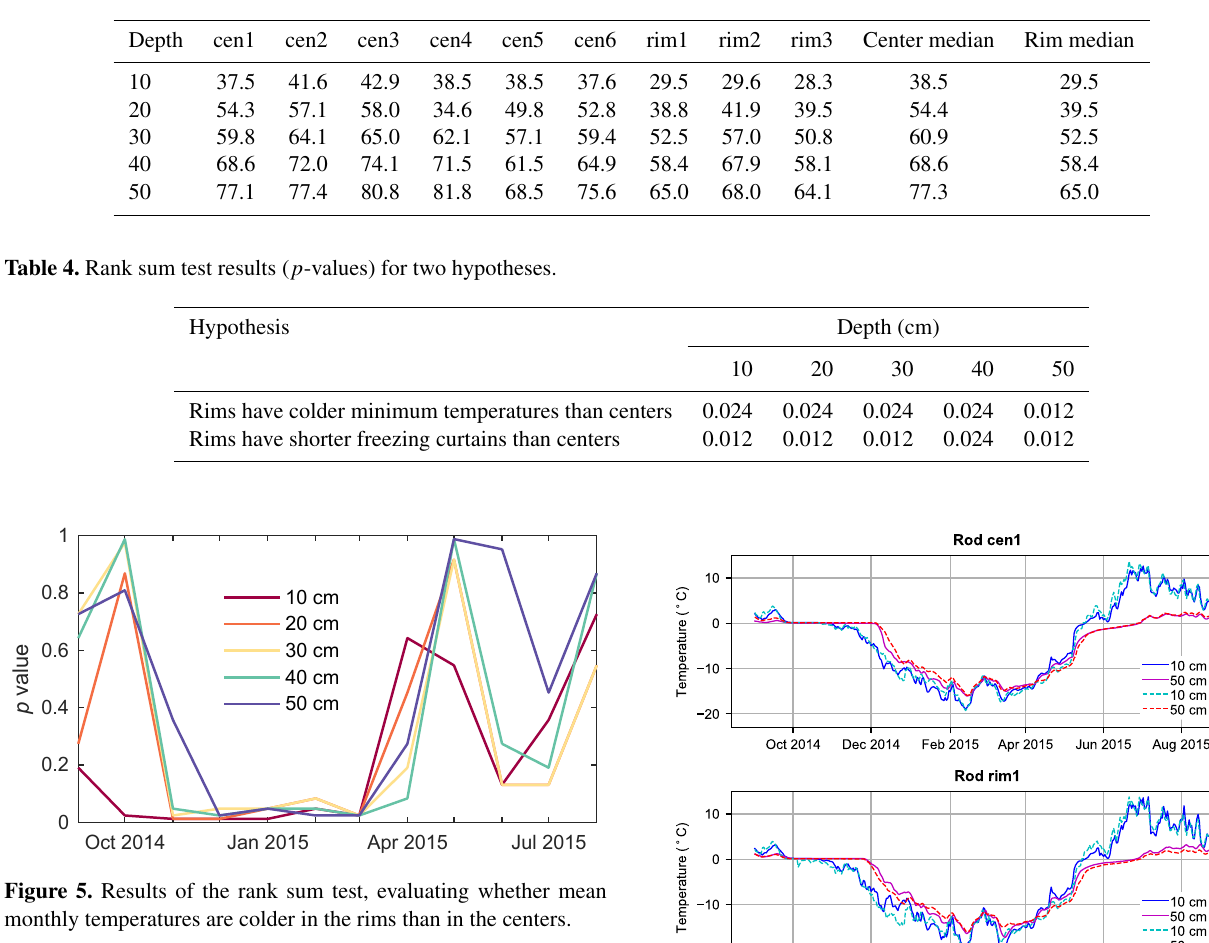
Table 3. Freezing curtain duration (days) at each sensor rod and depth (cm).